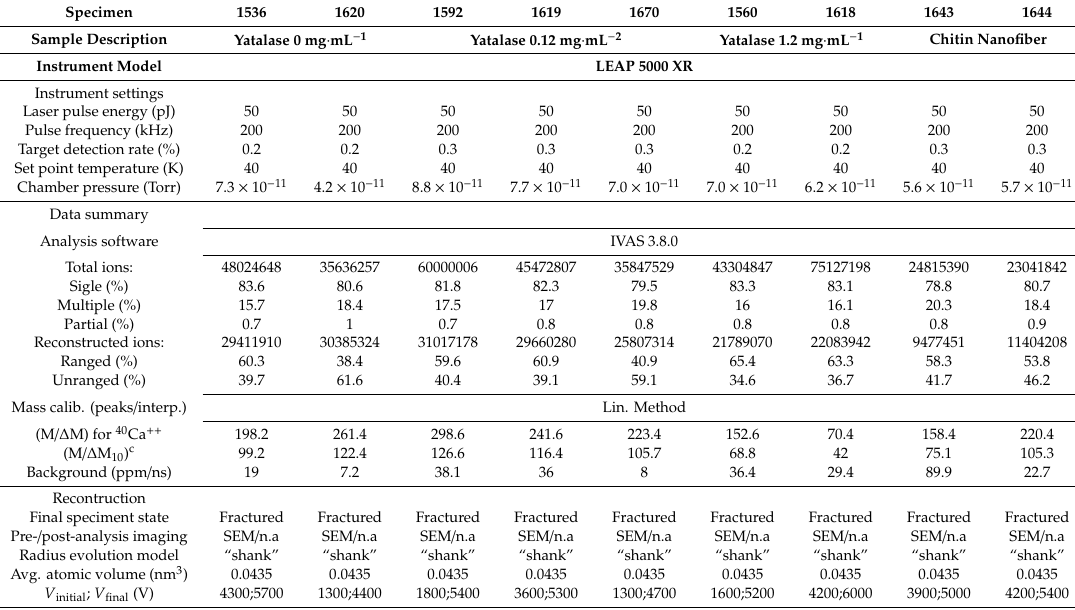
Table 1. LEAP running